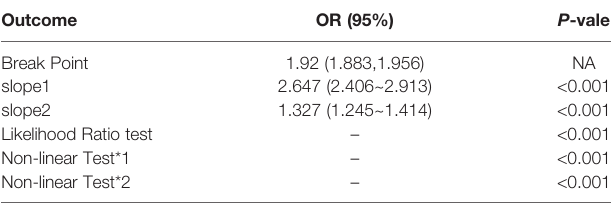
TABLE 4 | Threshold effect